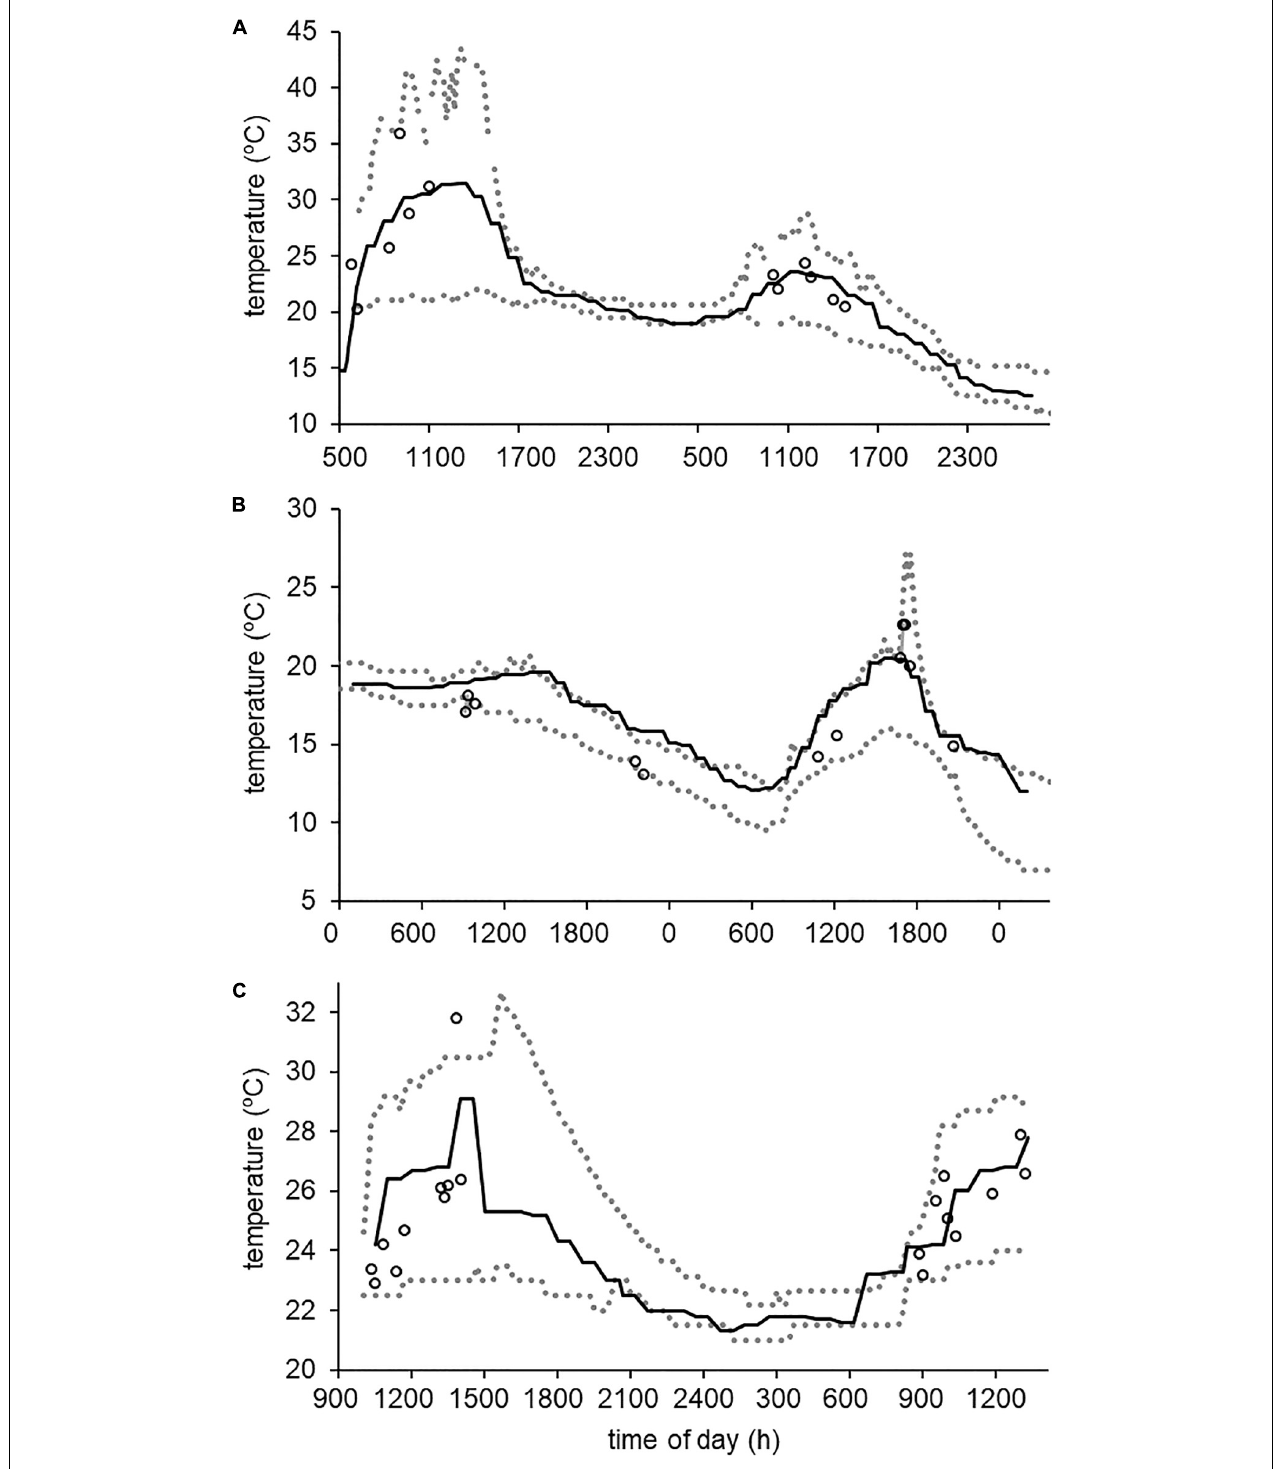
FIGURE 2 | Comparison of A. crepitans body temperatures (measured with IR thermometry, open circles), agar model temperatures (maximum and minimum iButton readings across all model types, shown as dotted gray lines) and Niche Mapper predicted skin temperatures (solid black lines) for our May 2015 surveys of (A) Cesar Creek State Park site #1, Ohio, United States, (B) Lincoln Lake City Park, Arkansas, United States, and (C) Atchafalaya Basin site #1, Louisiana, United States. For this time period, Niche Mapper predictions were frequently within the range observed among our agar models and only one measured A. crepitans had a body temperature that fell outside that